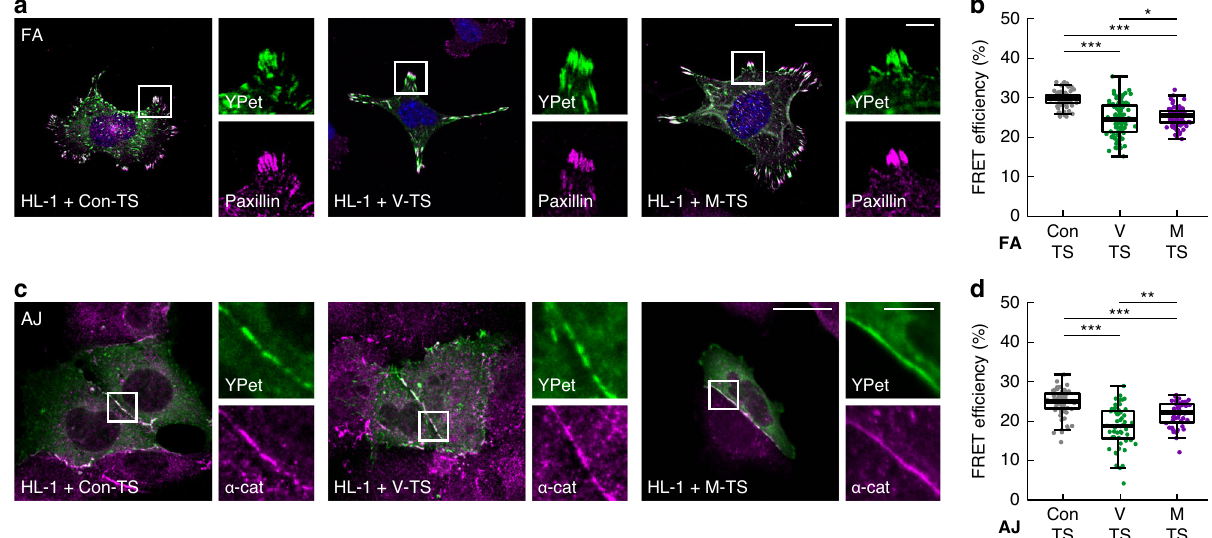
Fig. 3 Vinculin isoform-speci fi c differences in force transduction are observed in FAs and adherens junctions (AJs) of muscle cells. a Representative images of HL-1 cells expressing FL-based vinculin tension sensor (V-TS), metavinculin tension sensor (M-TS), and the no-force control (Con-TS) show localization of all fusion proteins to FAs (YPet), which are co-stained with a paxillin antibody. Nuclei are visualized with DAPI (blue). b FLIM measurements of FAs in HL-1 cells expressing FL-based sensors demonstrate vinculin isoform-speci fi c force transduction also in muscle cells. ( n = 81, 92, 84 cells). c Representative images of HL-1 cells expressing V-TS, M-TS, and Con-TS show localization of all tension sensors to AJs (YPet). The signal of co-stained α - catenin ( α -cat) is used to outline AJs. d FLIM measurements of AJs in HL-1 cells reveal vinculin isoform-speci fi c force transduction in cell – cell contacts. ( n = 65, 53, 48 cells). Boxplots show median, 25th, and 75th percentile with whiskers reaching the last data point within 1.5× interquartile range. Two-sided Kolmogorov – Smirnov test: *** p < 0.001, ** p < 0.01, * p < 0.05. Scale bar: 20 µ m, in zoom: 5 µ m. Source data and exact p values are provided in the Source Data fi